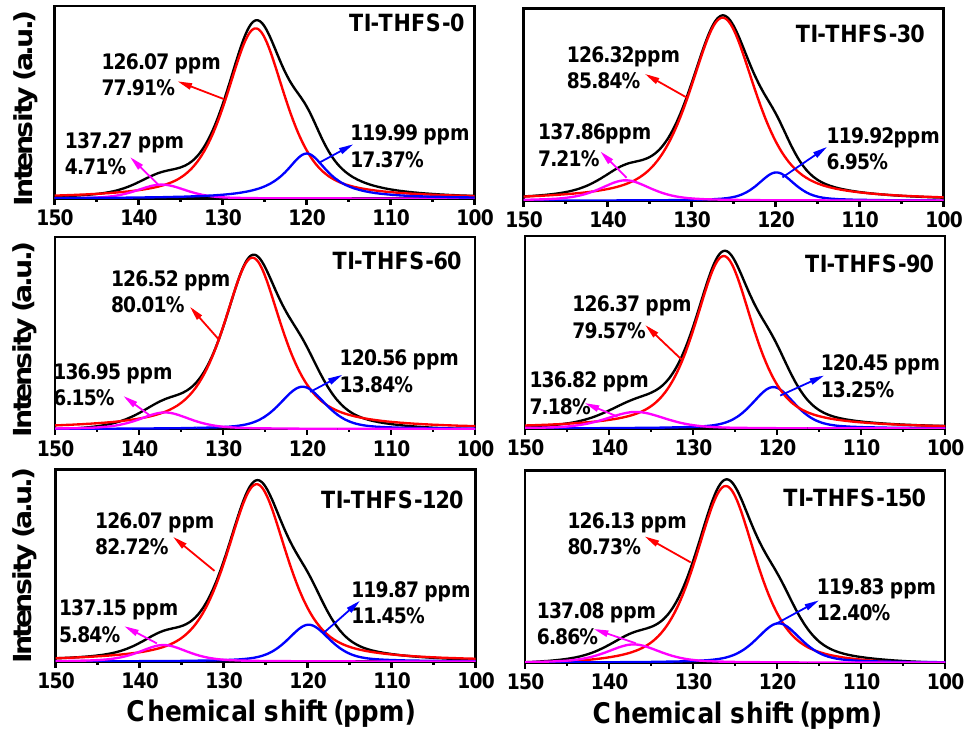
Figure 10. The classification of aromatic carbon in the TI − THFS fraction.